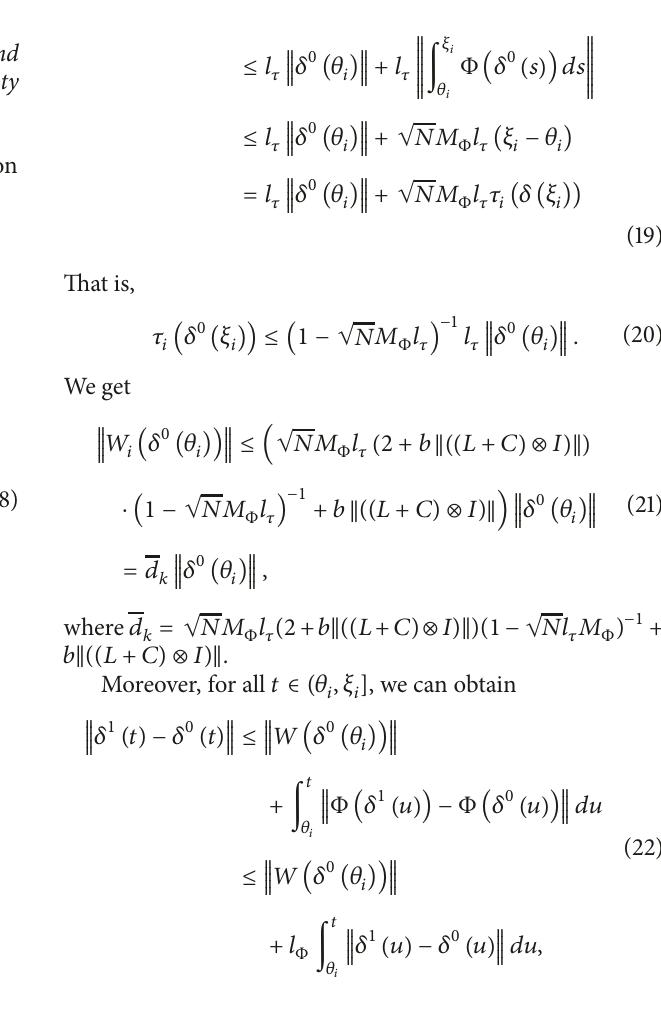
Figure 1: The 𝐵 − 𝑚𝑎𝑝 of the two